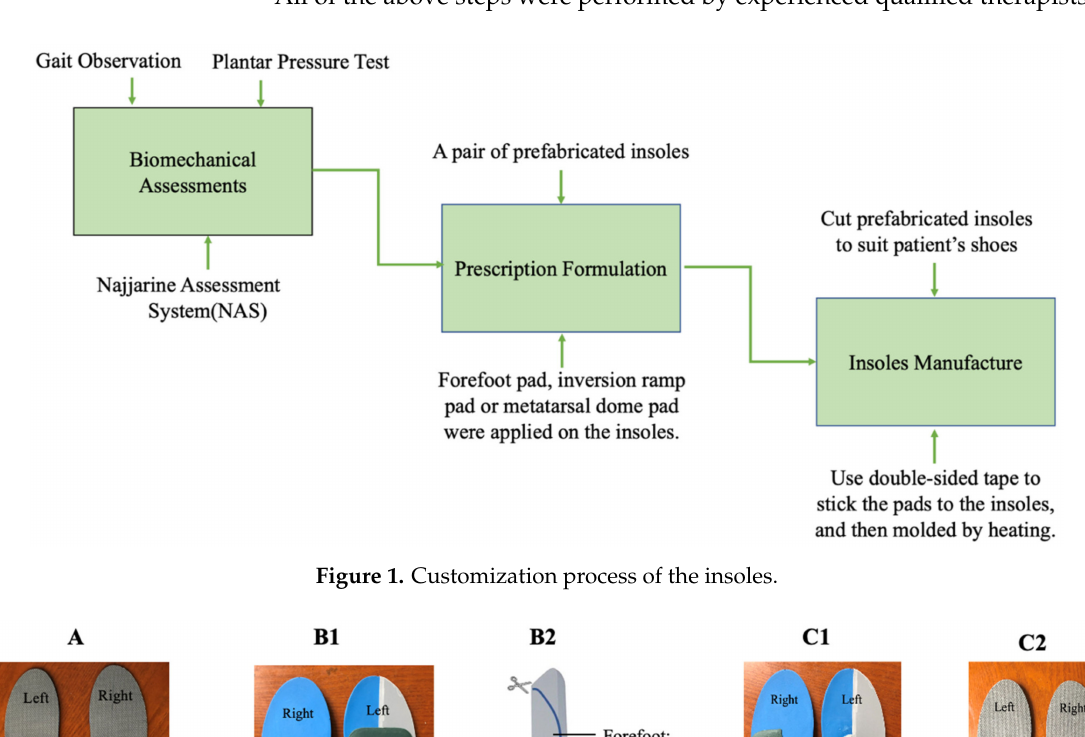
Figure 1. Customization process of the insoles.